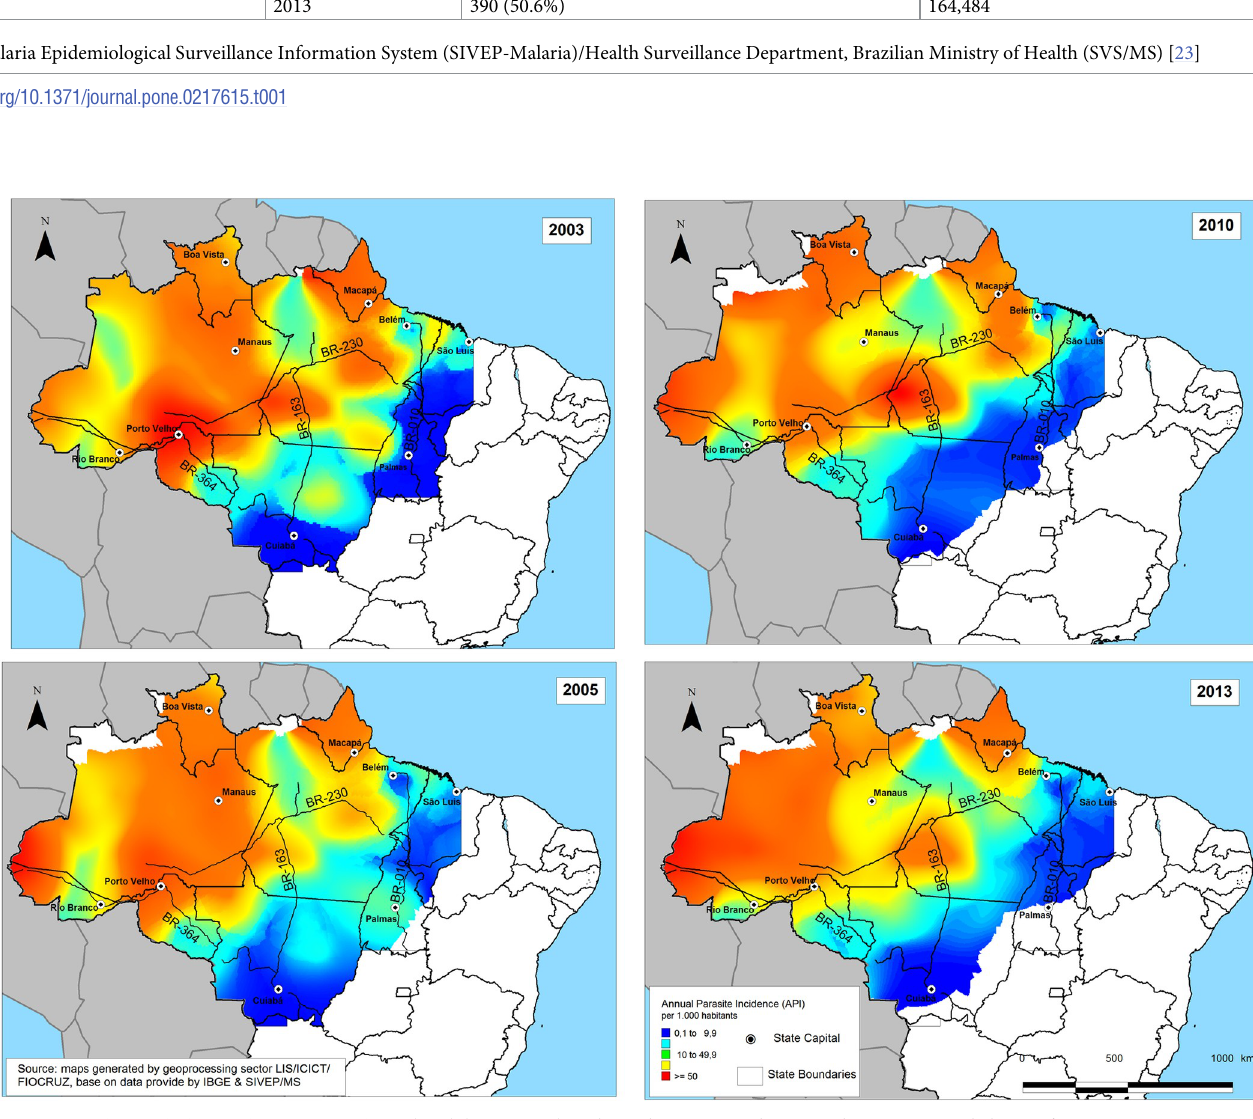
Fig 3. Spatial spread of annual parasite incidence (API) (2003–2013). Color codes correspond to API values per 1,000 inhabitants from 2003 to 2013.